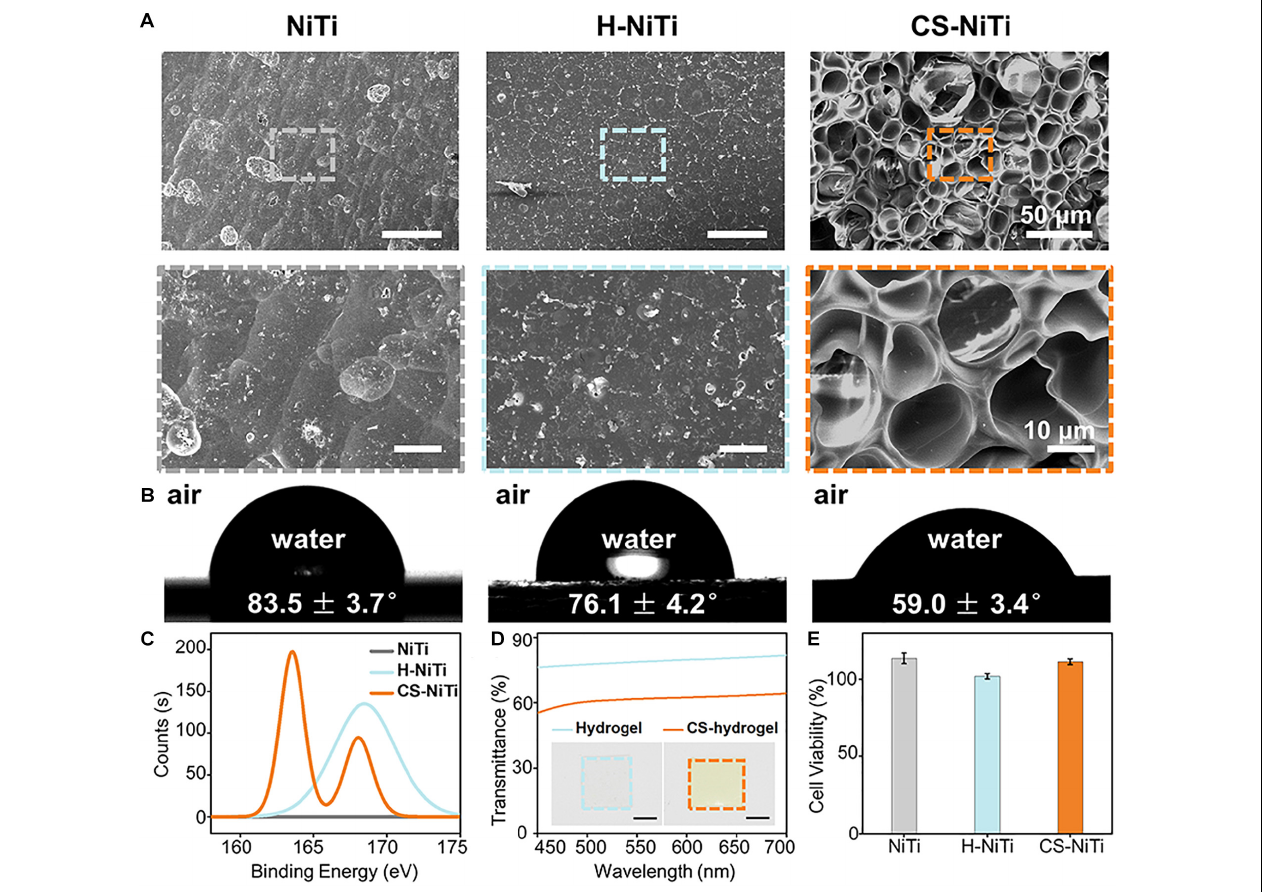
FIGURE 2 | Characterizations of CS-NiTi. SEM images (A) , water contact angles (WCAs; B) , X-ray photoelectron spectroscopy (XPS) spectra (C) , transmittance, (D) and biocompatibility (E) of pristine NiTi, H-NiTi, and CS-NiTi. The insets in (D) show the optical images of zwitterionic hydrogel and CS-hydrogel. Scale bar, 5 mm for (D)